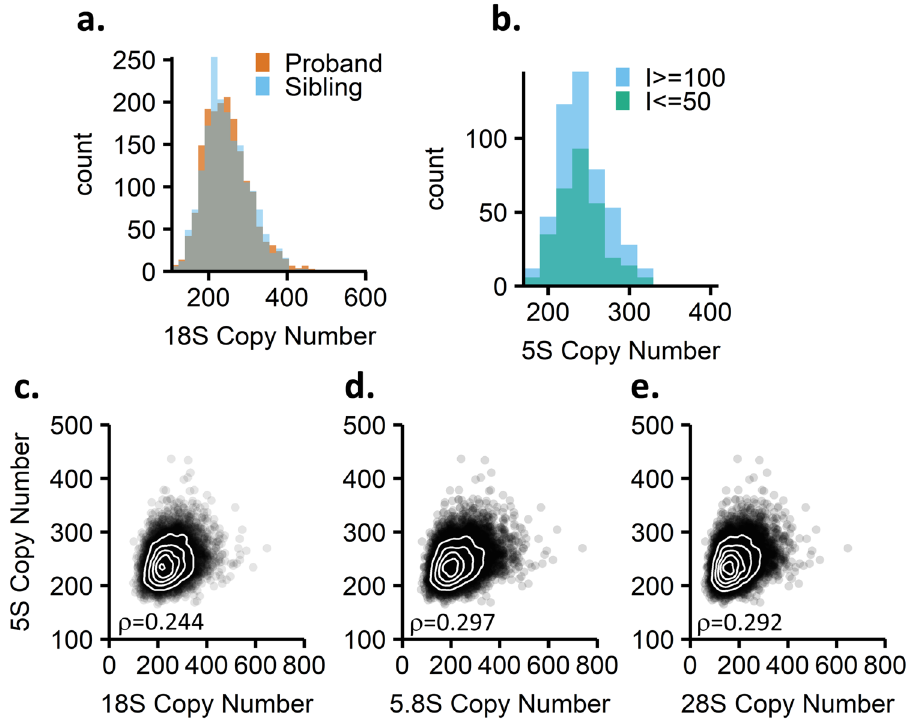
Figure 1. rDNA copy number estimates and correlations of 45S and 5S rDNA regions in the Simons Simplex Collection. ( a ) rDNA copy number distributions for probands (n = 1774) and unaffected siblings (n = 1774) in the Simons Simplex Collection. Paired t-test p-value: 0.937. ( b ) Comparison of 18S copy number in probands with low (I < = 50, n = 298) and high (I > = 100, n = 500) IQ scores. Welch Two Sample t-test p-value = 0.01533, average difference between groups is 9 copies. ( c – e ) Correlations of each the 18S, 5.8S, and 28S regions of the 45S rDNA array to the 5S rDNA array with Spearman’s rho indicated (n = 7210).